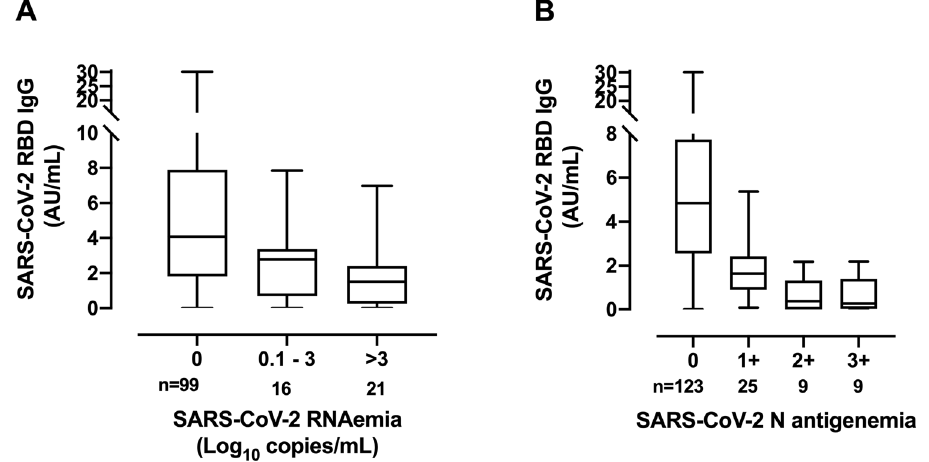
Figure 3. Box-plot depicting anti-SARS-CoV-2-S (RBD) antibody levels in plasma according to ( A ) the magnitude of virus RNAemia (in copies/ml) or ( B ) N-antigenemia (graded as described in the methods